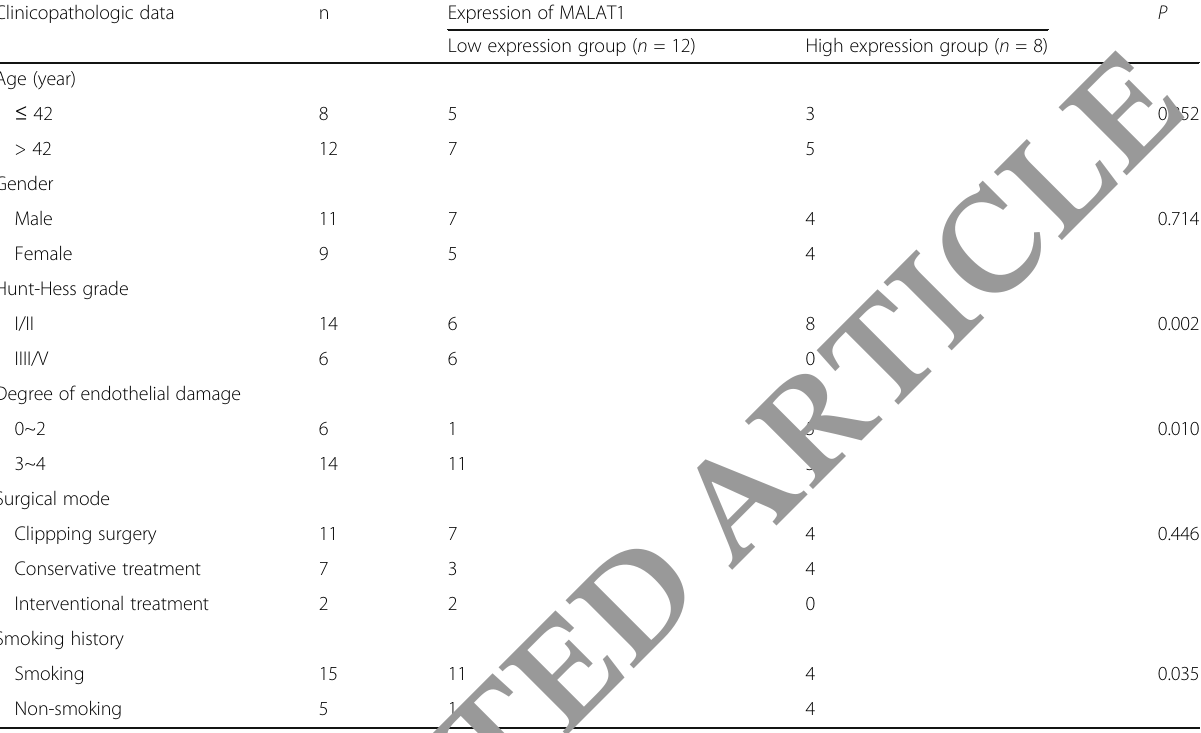
Table 2 Relationship between relative expression of MALAT1 and clinicopathological features in patients with intracranial aneurysm Clinicopathologic data